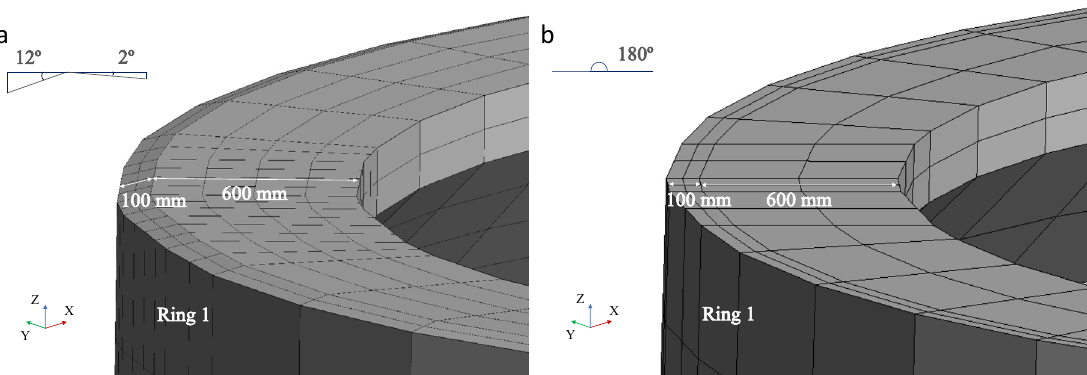
Figure 12. Models with (a) and without (b) interlock mechanism in the concrete ‐ concrete contact of two adjacent SFRC